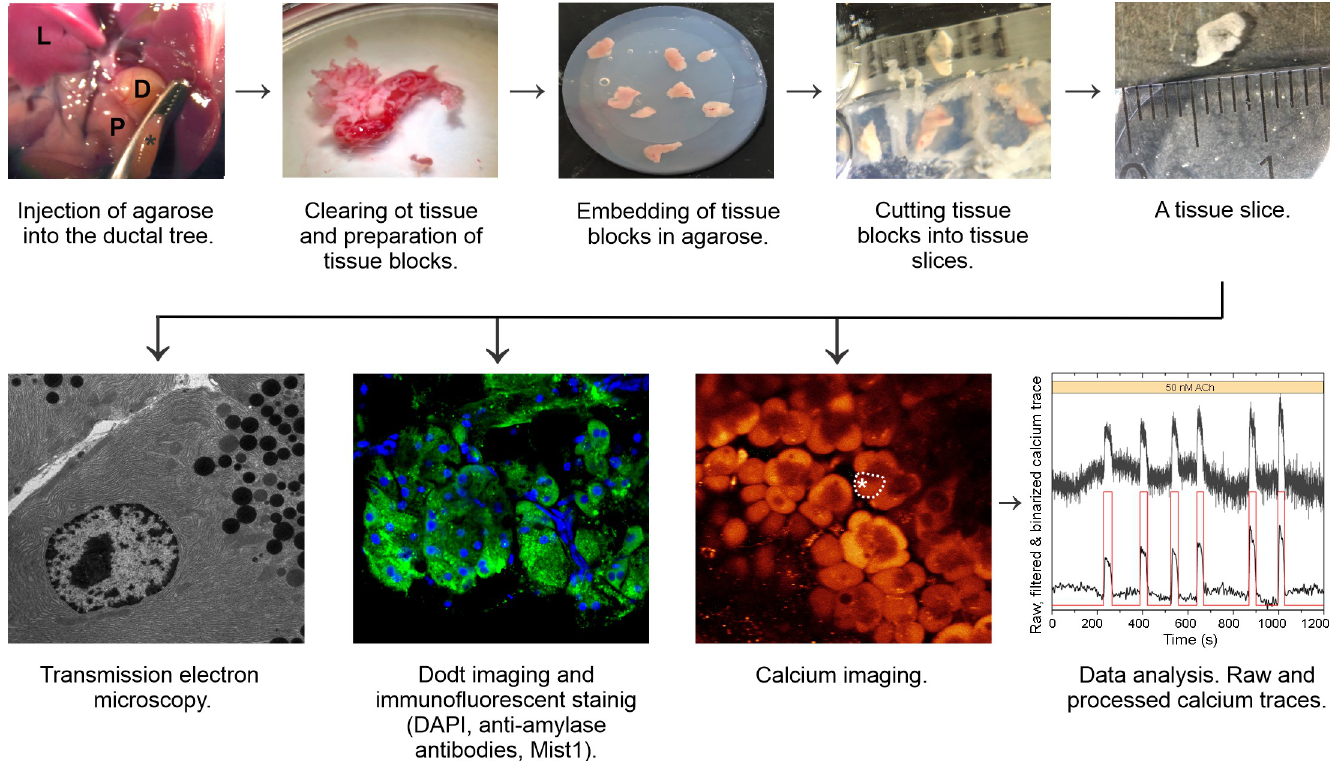
Fig 1. Flowchart for studying calcium responses in acinar cells in mouse pancreas tissue slices, from the injection of agarose into the ductal tree of the mouse pancreas and preparation of tissue slices to structural and functional imaging with data analysis. L, liver; P, pancreas; D, duodenum; asterisks, clamped major duodenal